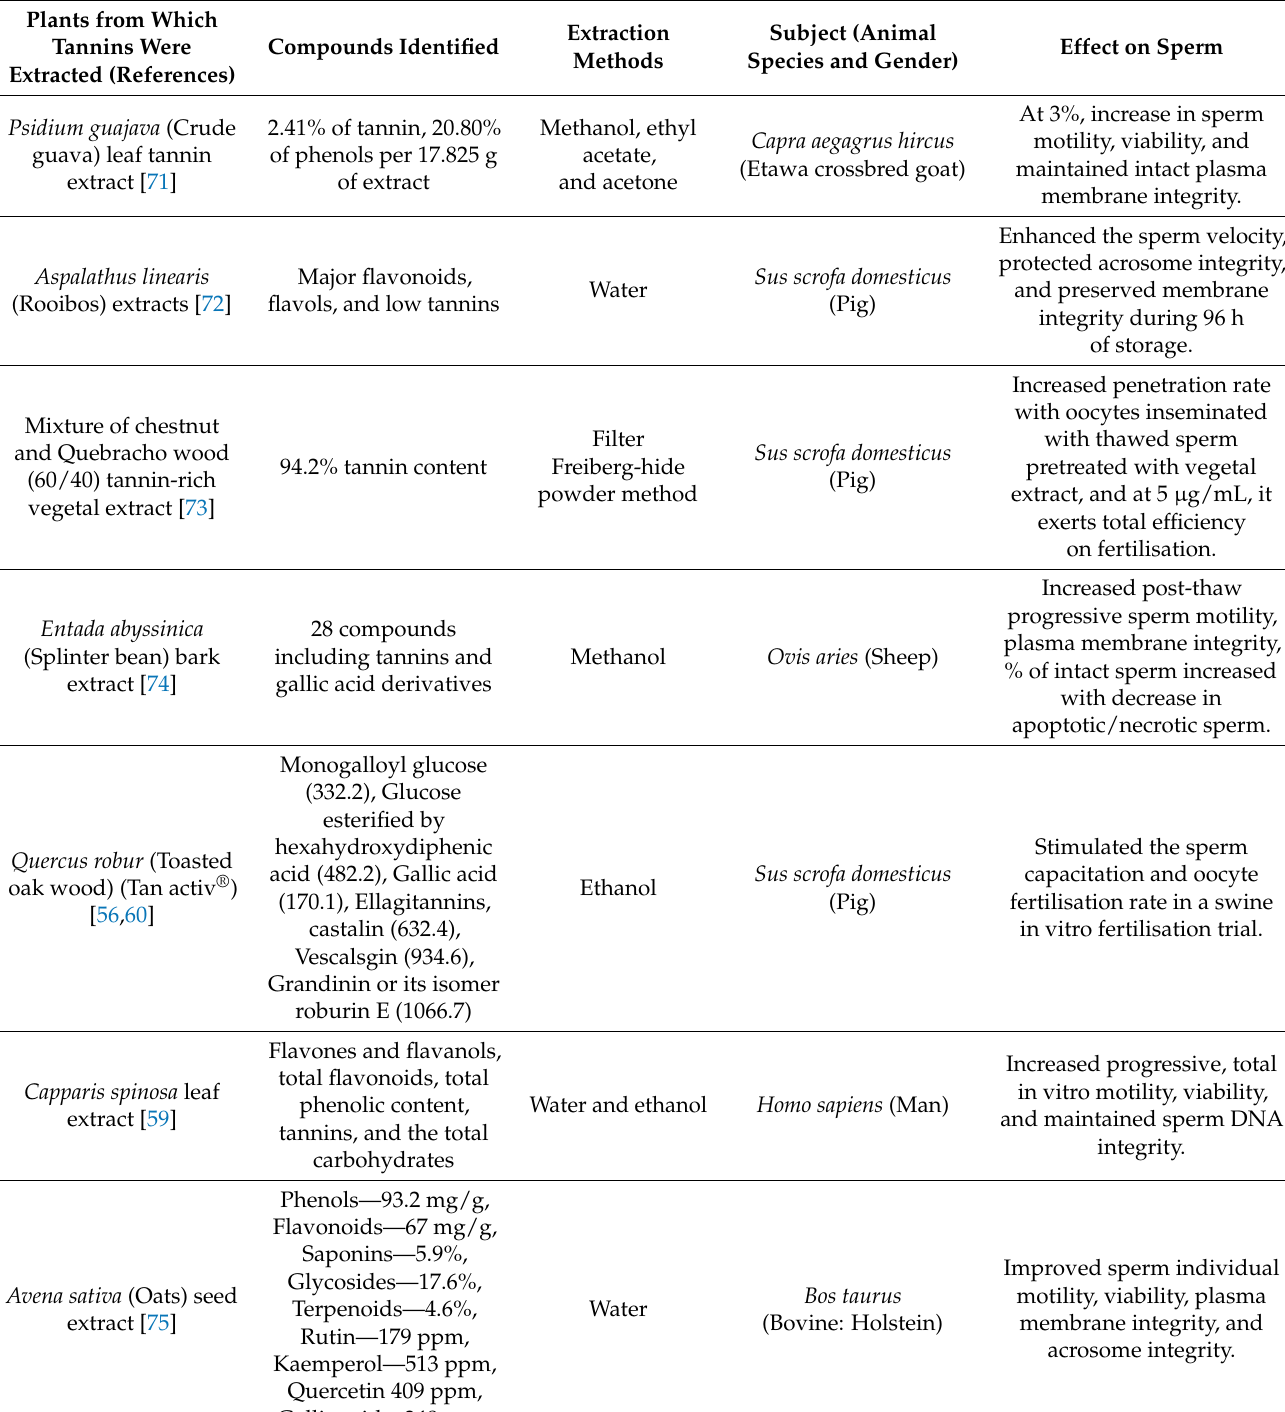
Table 2. Tannin-rich extracts used as semen-protective agents in humans and various domestic